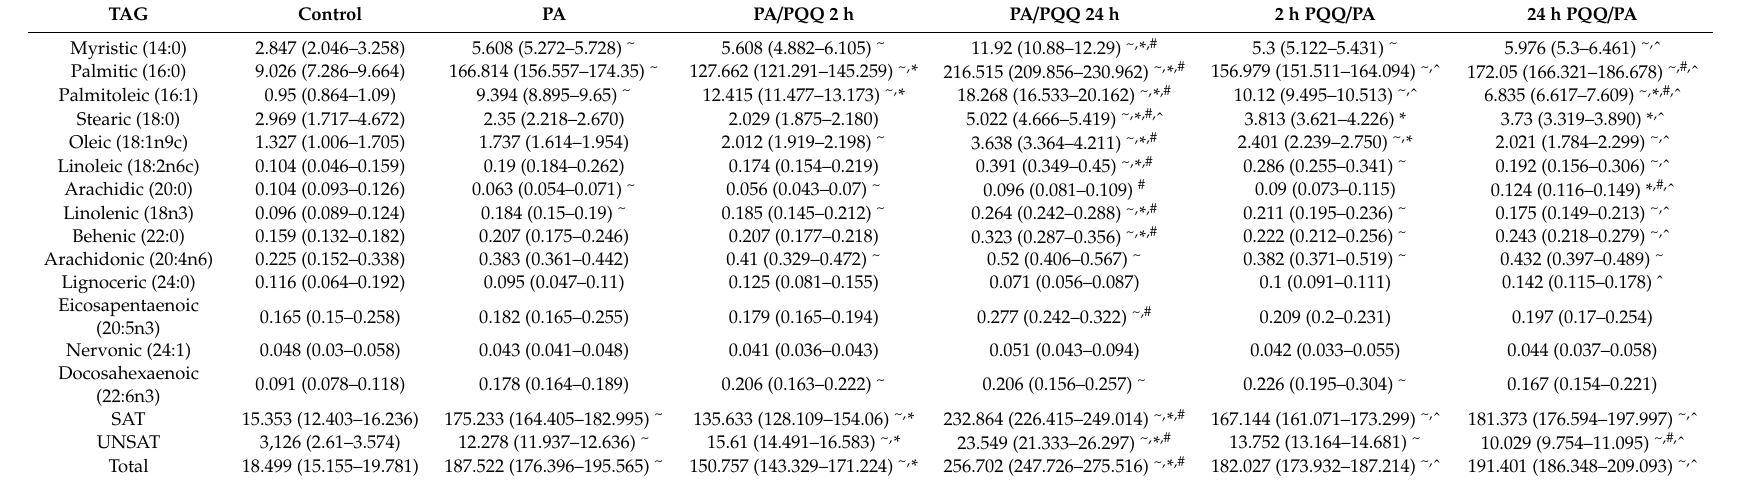
Table A3. Triacylglycerols (TAG) content and composition in L6 muscle cells. The values (nmol mg − 1 of protein) are expressed as: median (25%–75%) based on six independent determinations. The Kruskal–Wallis test followed by a post hoc adjustment was applied. ~ p < 0.05, PA versus control; * p < 0.05, study group (co-cultured with PQQ) versus PA; # p < 0.05, time-dependent di ff erences (long- versus short-time incubation with PQQ); ˆ p < 0.05, sequence-dependent di ff erences (pre-incubation with PQQ versus post-incubation with PQQ). PA: palmitic acid; PQQ: pyrroloquinoline quinone; SAT: saturated fatty acids; UNSAT: unsaturated fatty